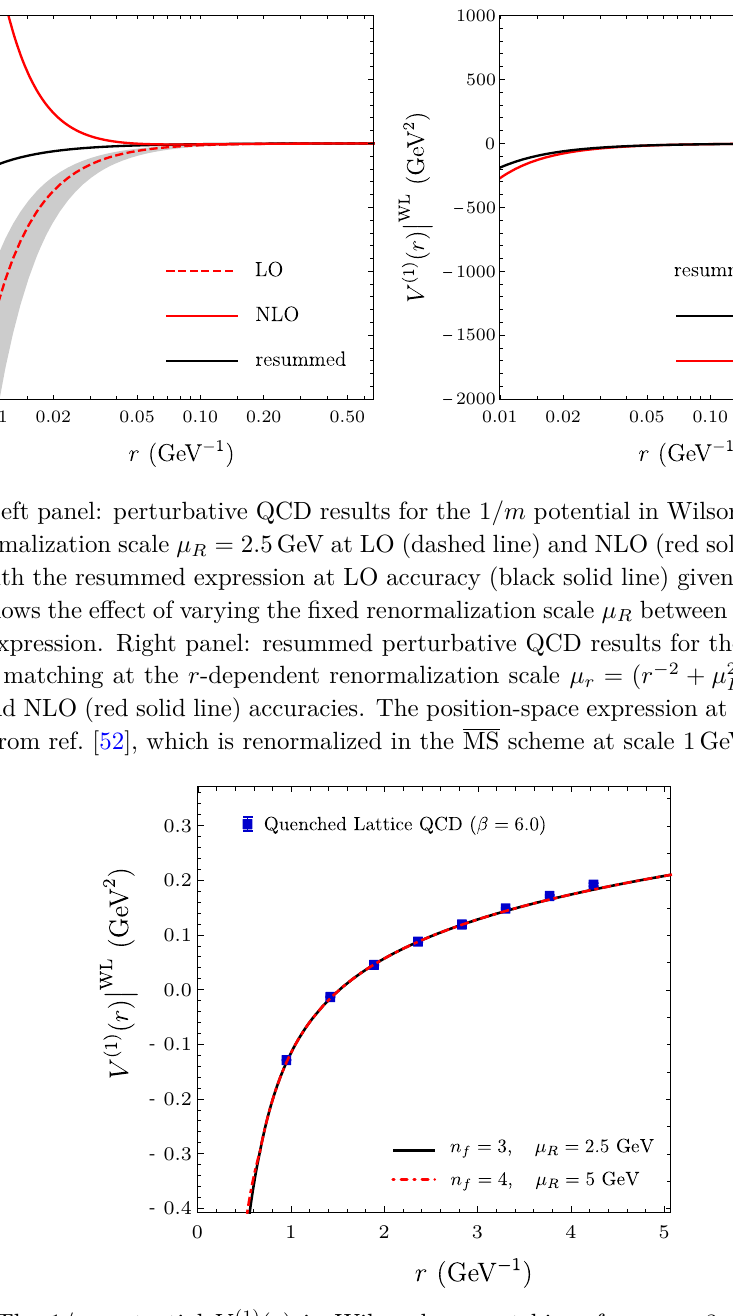
Figure 4 . The 1 /m potential V (1) ( r ) in Wilson loop matching, for n f = 3 and µ R = 2 . 5 GeV (black solid line), and for n f = 4 and µ R = 5 GeV (red dot-dashed line), shown with quenched lattice QCD results with lattice coupling β = 6 . 0 in ref. [49], shifted vertically to match eq.